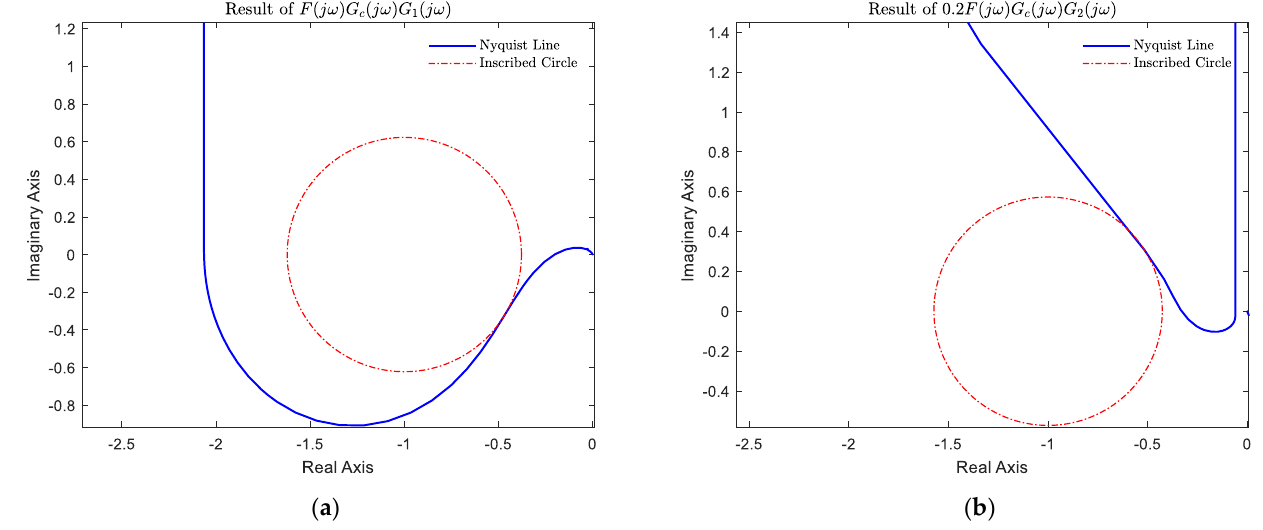
Figure 7. Results of sensitivity analysis. ( a ) Nyquist plot and sensitivity inscribed circles. 𝐹(𝑗𝜔)𝐺 𝑐 (𝑗𝜔)𝐺 1 (𝑗𝜔) ( b ) Nyquist plot and sensitivity inscribed circles. 0.2𝐹(𝑗𝜔)𝐺 𝑐 (𝑗𝜔)𝐺 2 (𝑗𝜔) .